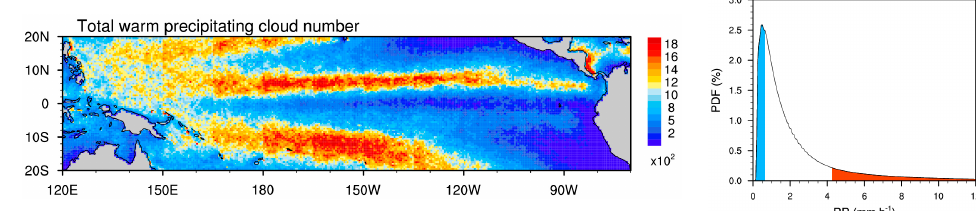
Figure 1. Distribution of number ( left ) and the probability distribution function (PDF) of the near-surface rain rate (RR) for warm precipitating cloud (WPC) ( right ) in the tropical Pacific Ocean (blue: extreme-light WPC; red: extreme-heavy WPC).